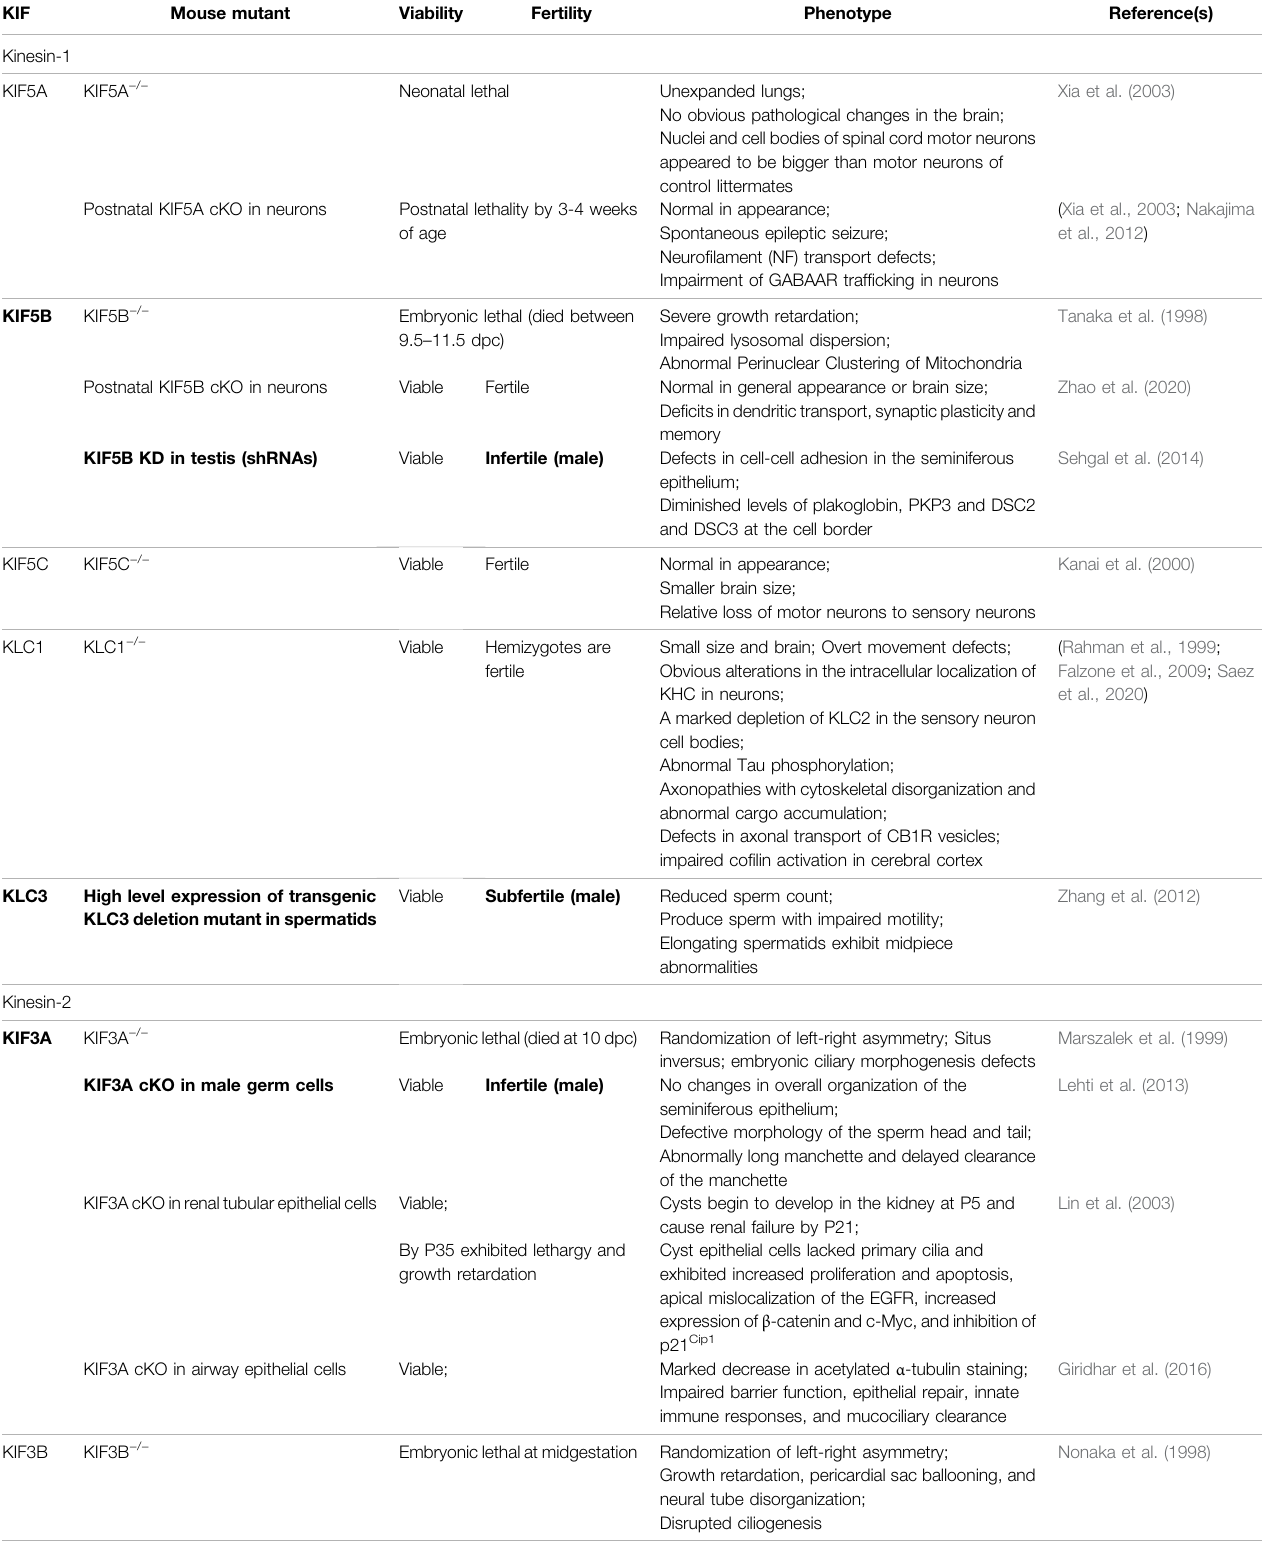
TABLE 2 | Phenotypes in KIF mutant mice/embryos a